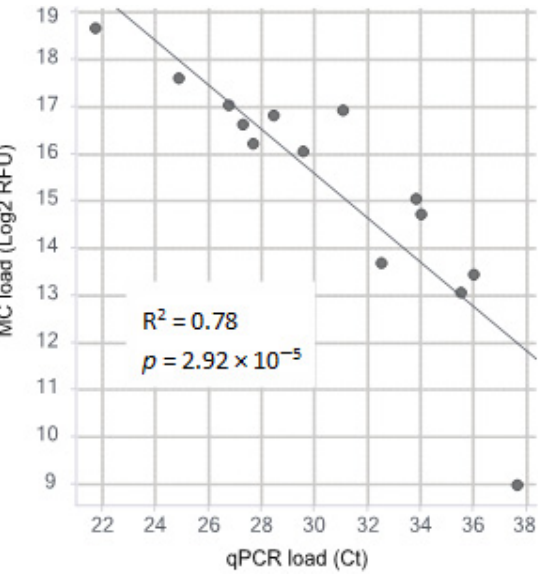
Figure 1. A linear correlation can be seen between Ct values as measured by specific qPCR and MC load, as measured by Log 2 transformed Relative Fluorescence Units (RFU) (R 2 = 0.78, p = 2.92 × 10 − 5 ).